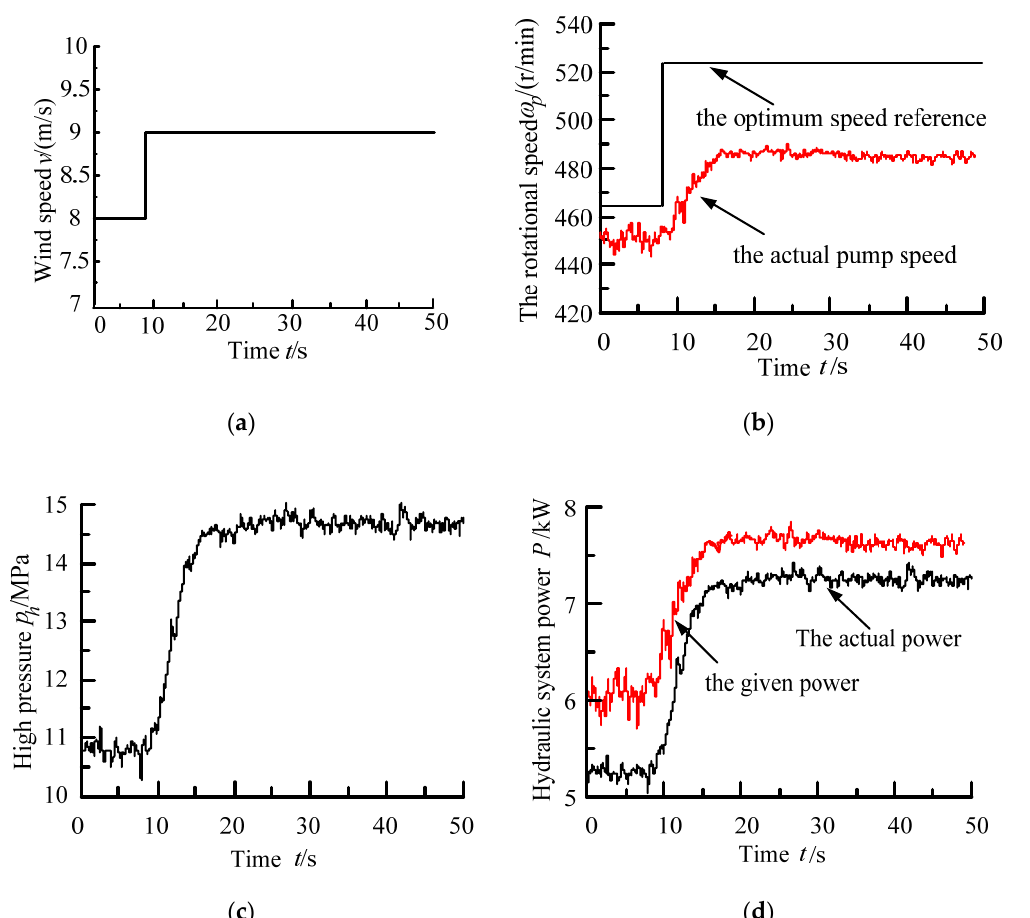
Figure 10. The system response curve under the step wind speed. ( a ) the wind speed; ( b ) the pump speed; ( c ) the high pressure; ( d ) the output power.